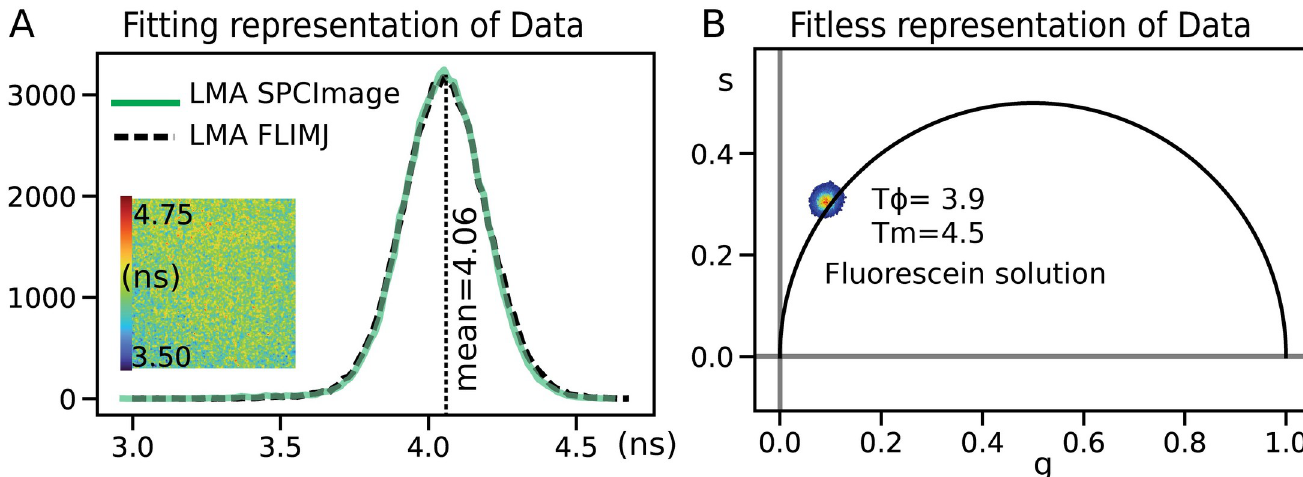
Fig 4. A) Validation of FLIMLib LMA lifetime estimation against hardware vendor-provided software (SPCImage) for fluorescein in water. B) The phasor plot for the data is also shown as a proof of principle of the FLIMLib Phasor function for fit-less estimation of lifetime parameters. The two parallels of lifetime histograms and phasor plots are the current laboratory standards for FLIM analysis. The phasor is plotted on a universal circle derived from the endpoints of the fit-range (117 MHz).